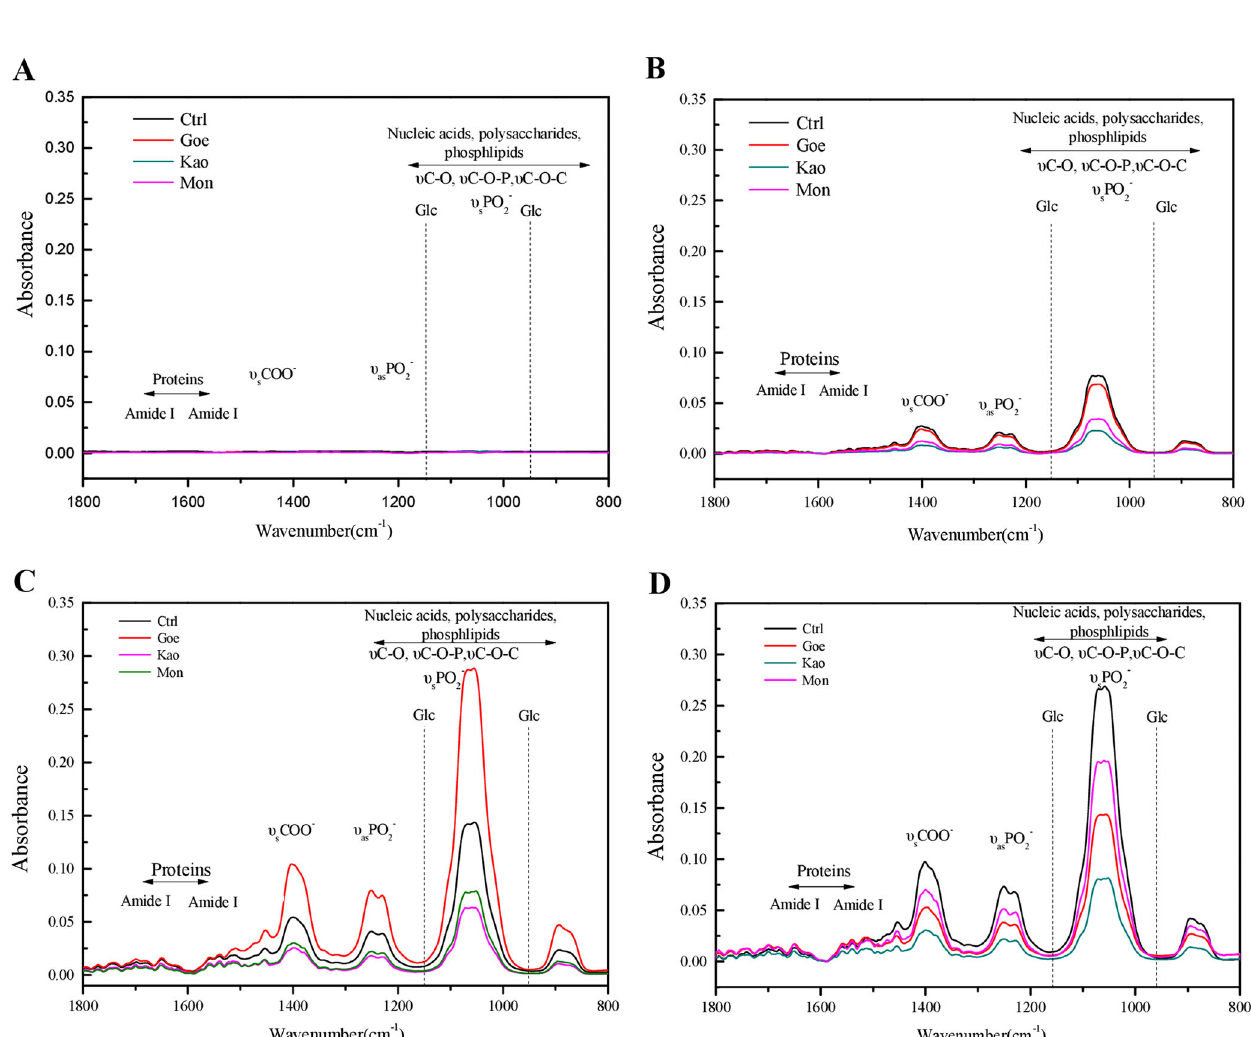
Fig. 2 ATR-FTIR assays of the bio fi lm formation at 24 ( a ), 36 ( b ), 48 ( c ), and 60 h ( d ). At each time point, the absorbance spectra were given for control (Ctrl), goethite (Goe), montmorillonite (Mon), and kaolinite (Kao) seperatedly, as indicated in fi gure legends. Representive peaks (nucleic acids, polysaccharides, proteins, etc.) were labeled on the top of curves,